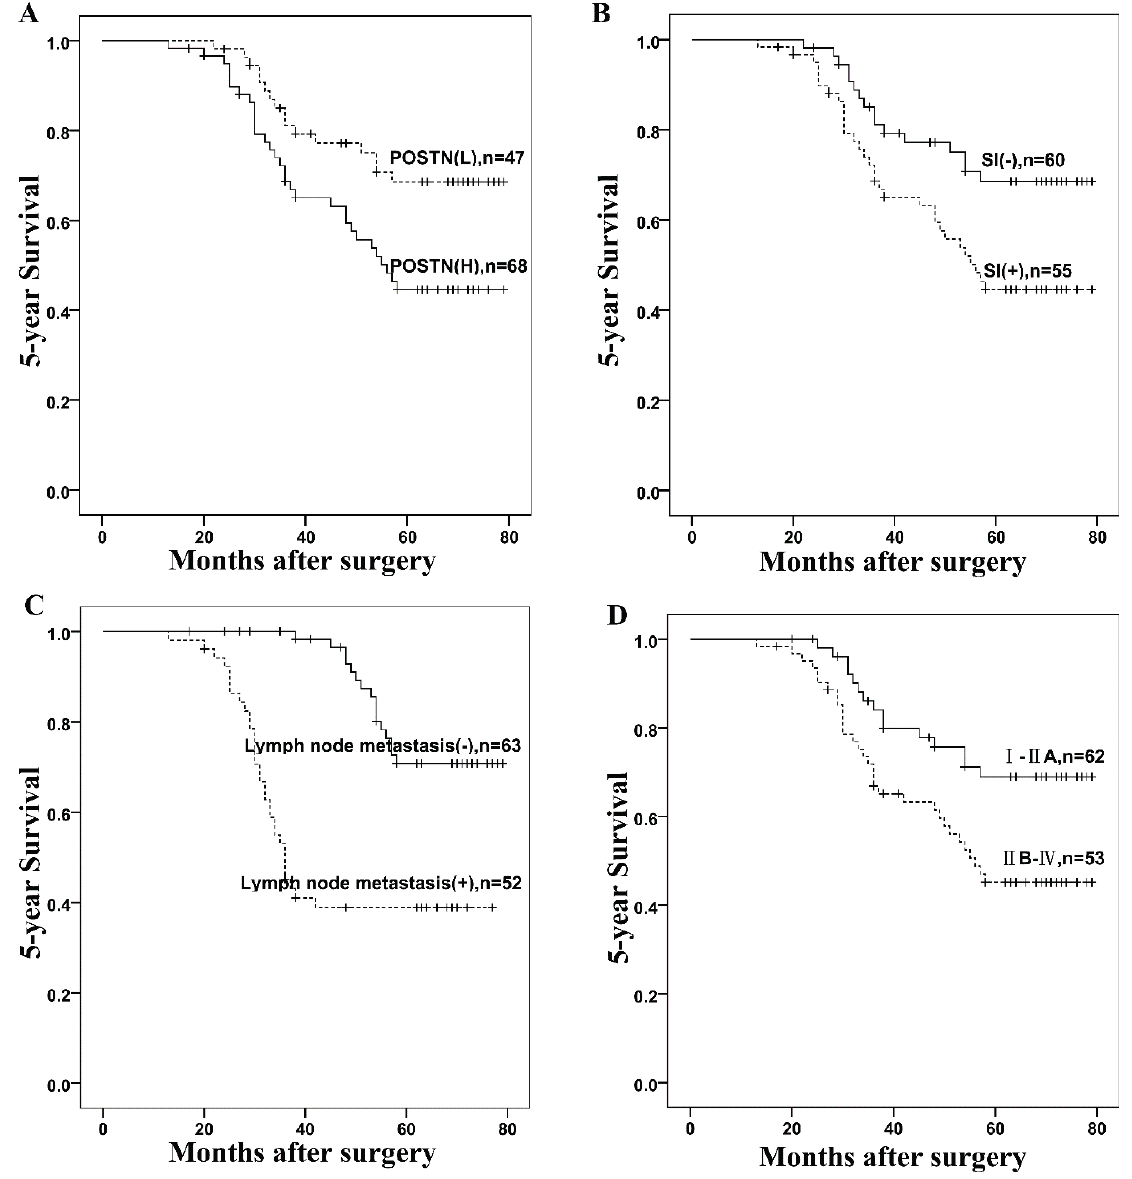
Figure 2. Kaplan-Meier analysis of five-year survival rates in 115 colorectal cancer patients according to ( A ) POSTN expression ( p = 0.022); ( B ) Serosal invasion (SI) ( p < 0.001); ( C ) Lymph nodes metastasis ( p < 0.001); and ( D ) TNM stage ( p < 0.001). Vertical bars represent censored patients. 2.4. Univariate and Multivariate Cox Analysis for Prognosis of Patients with Colorectal Cancer Using univariate analysis, we found statistically significant correlations between overall survival and POSTN level, serosal invasion, lymph nodes metastasis and tumor stage (Table 2). We found that lymph nodes metastasis ( p < 0.001) and POSTN expression ( p = 0.044) were prognostic factors for overall survival rates (Table